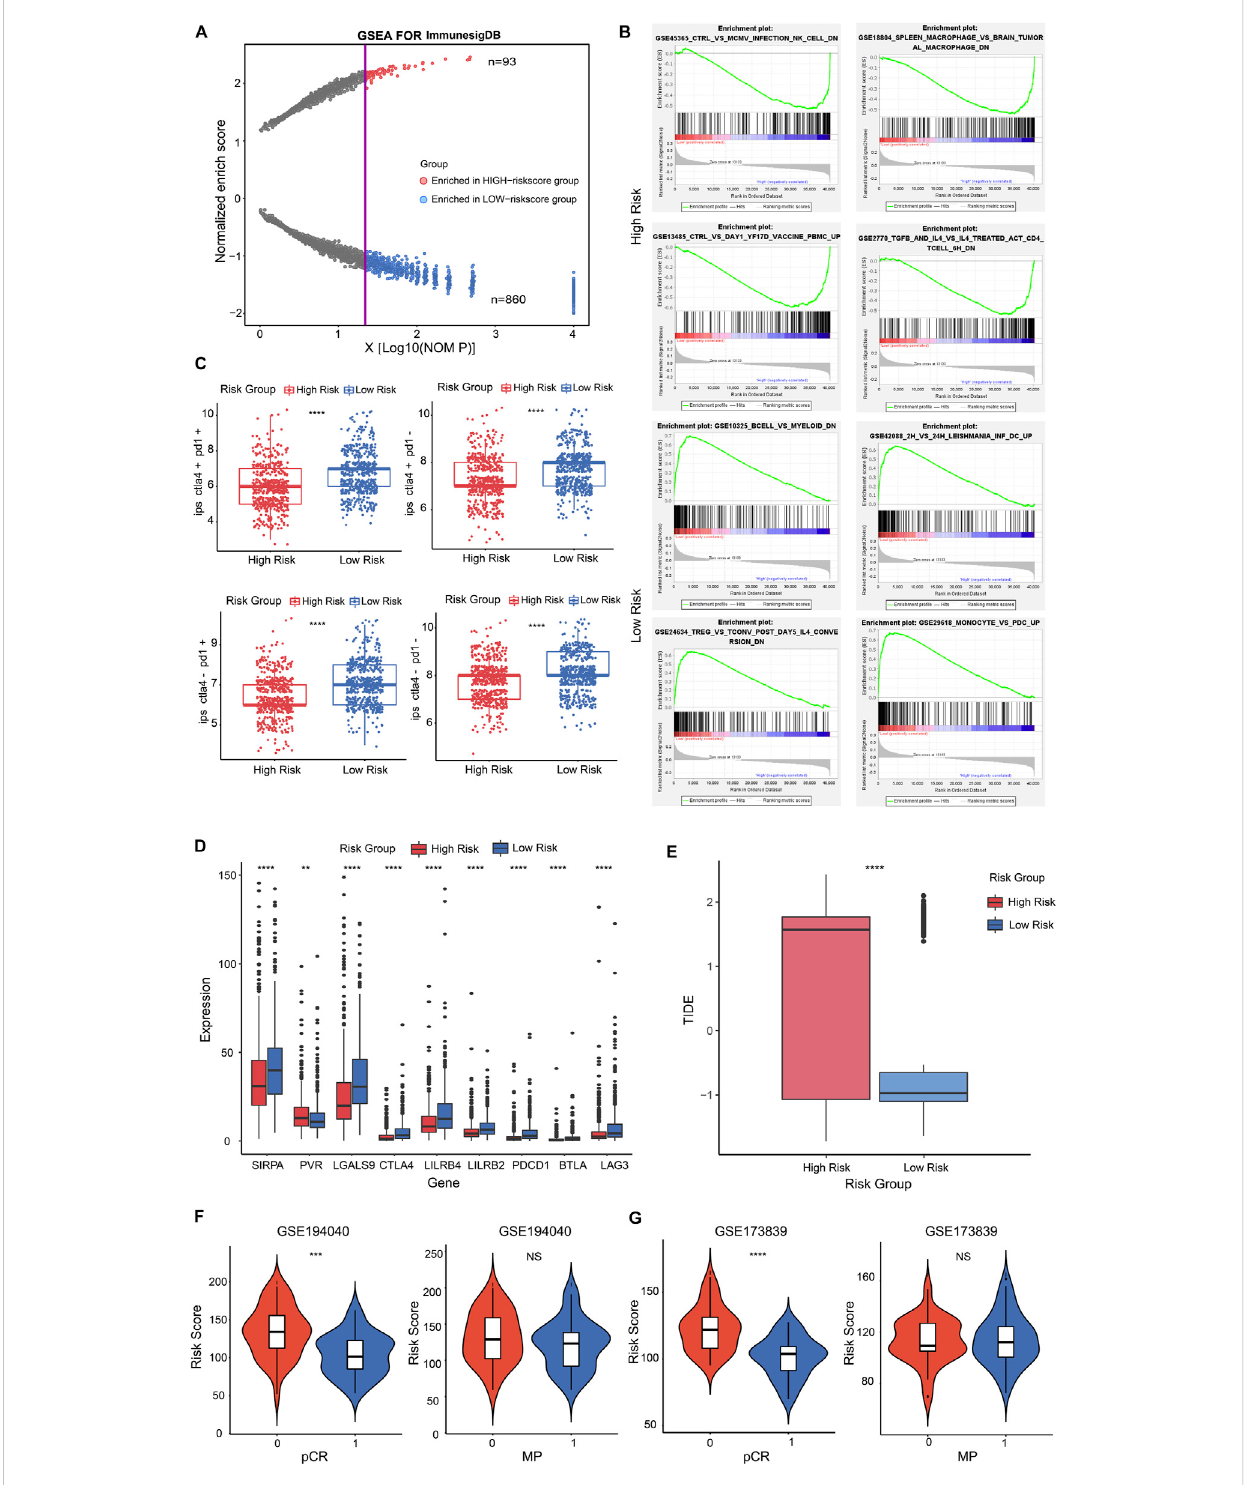
FIGURE 6 The immune signature and immunotherapy bene fi t of the risk score in BRCA patients. (A) Dot plot described the signi fi cantly enriched immune features in high-risk and low-risk groups. The red dots represented the immune features enriched in the high-risk group; blue dots represented in low- riskgroup. (B) RepresentativelyimmunecharacteristicsinGSEAwereshowninahigh-riskgroupandalow-riskgroup. (C) Therelationshipwasestimated betweenriskscoreandIPSscore. (D) BoxplotperformedthedifferentexpressionofrepresentativeICPsinthehighandlow-riskgroups. (E) Boxplot showed the relationship between TIDE score and two risk score groups. (F,G) Violin plot illustrated the interrelation between risk score and patients ’ distribution from the two pCR groups in GSE194040 cohort (F, left panel) and GSE173839 cohort [ (G) , left panel]; pCR represented the status of a pathological complete response; 1 = complete response; 0 = failed complete response. Violin plot descripted the correlation between risk score and patients ’ distribution from the two MP groups in GSE194040 cohort [ (F) , right panel] and GSE173839 cohort (G, right panel); MP represented